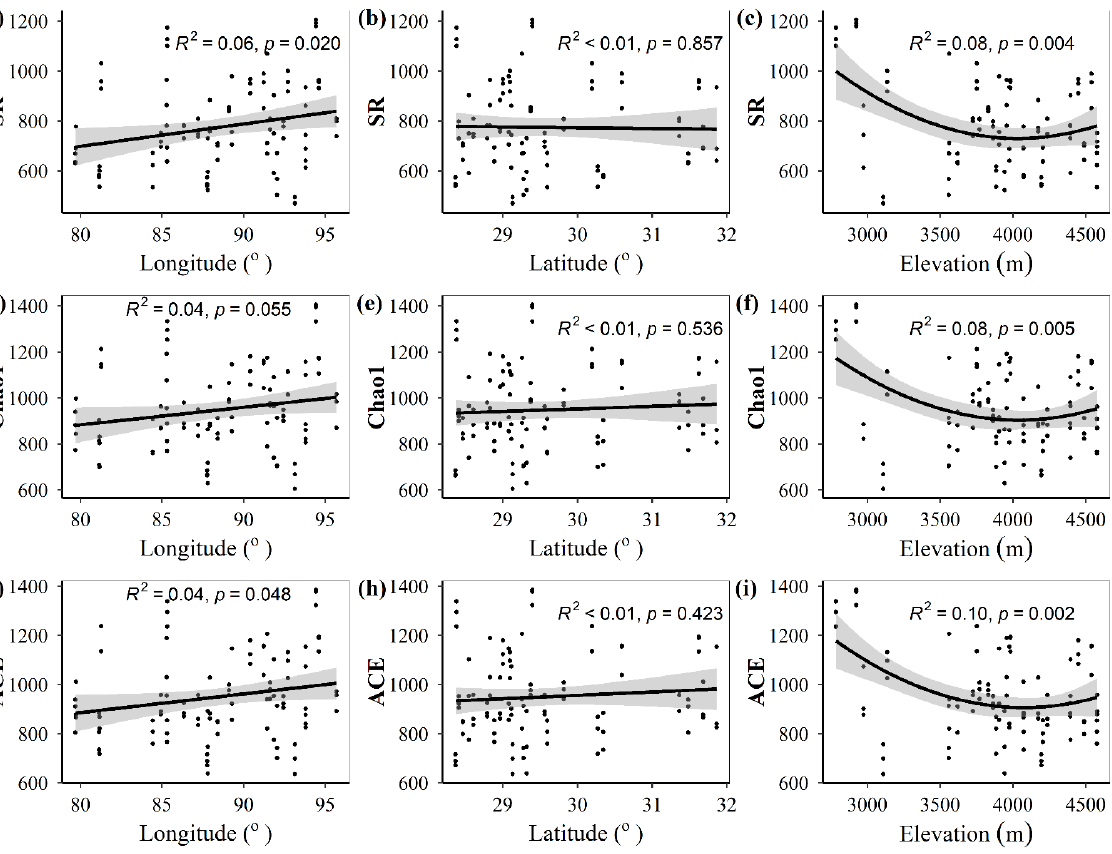
Figure A12. Cont